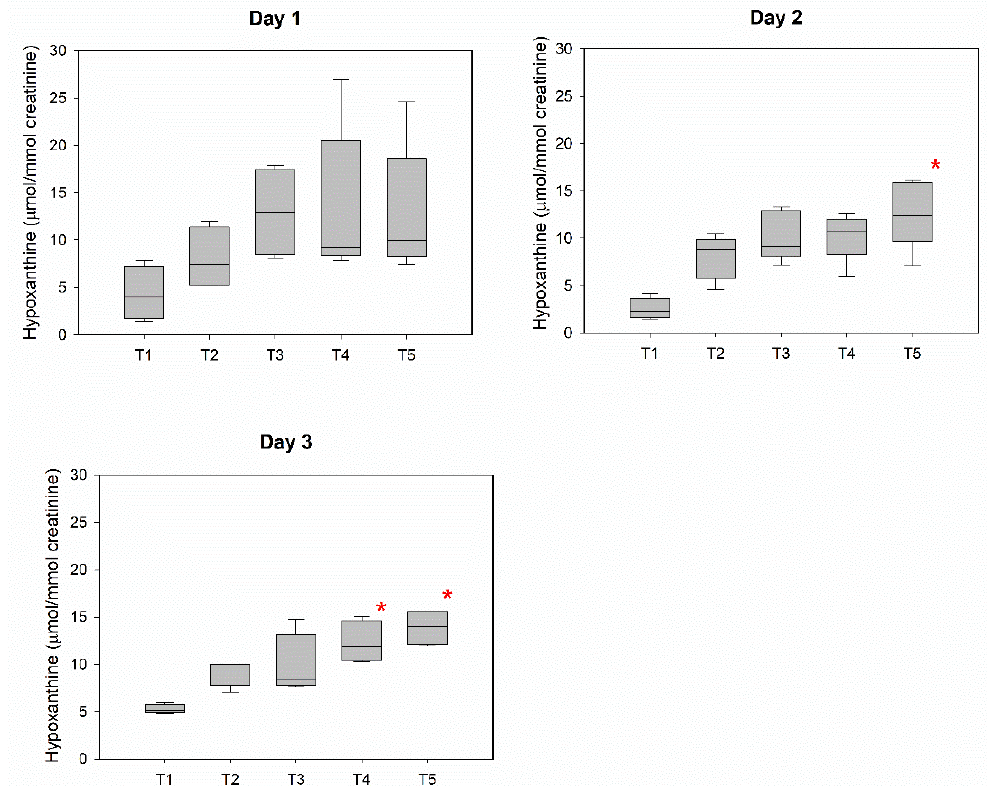
Figure 5. The boxplot of Hyp for all the individuals across the sampling time for day 1, day 2, and day 3 of diving. The groups which are statistically different from T1 are shown with a red asterisk ( p < 0.05).